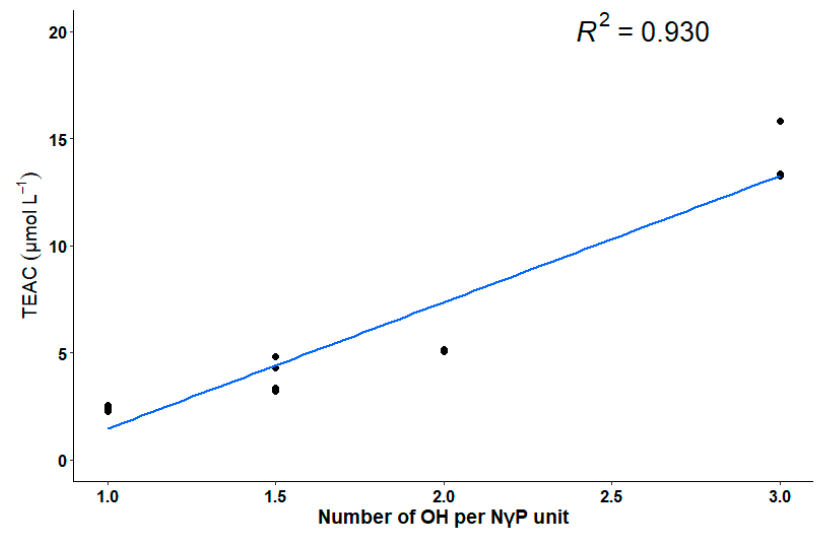
Figure 3. Linear relation between the number of hydroxyl groups per N γ P unit and the TEAC.